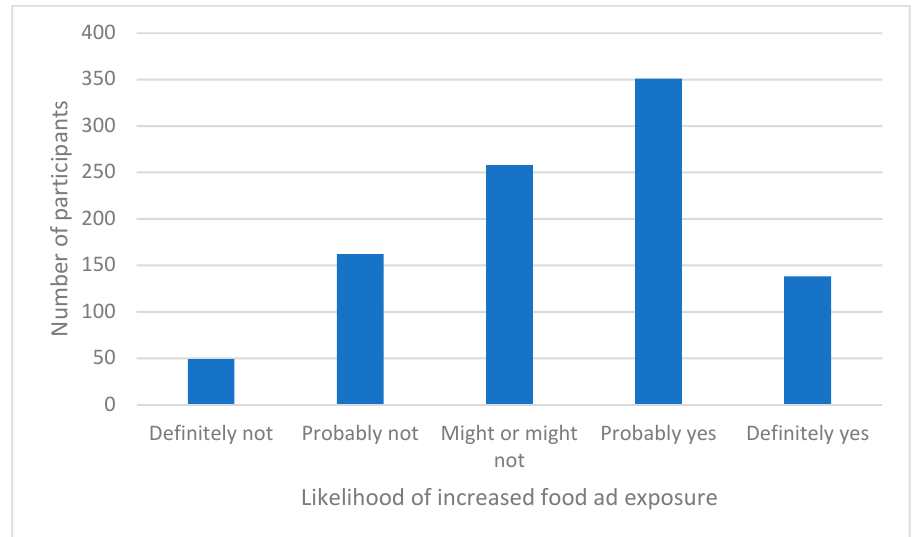
Figure 8 . Perceived likelihood of increased exposure to food advertisements among household members .